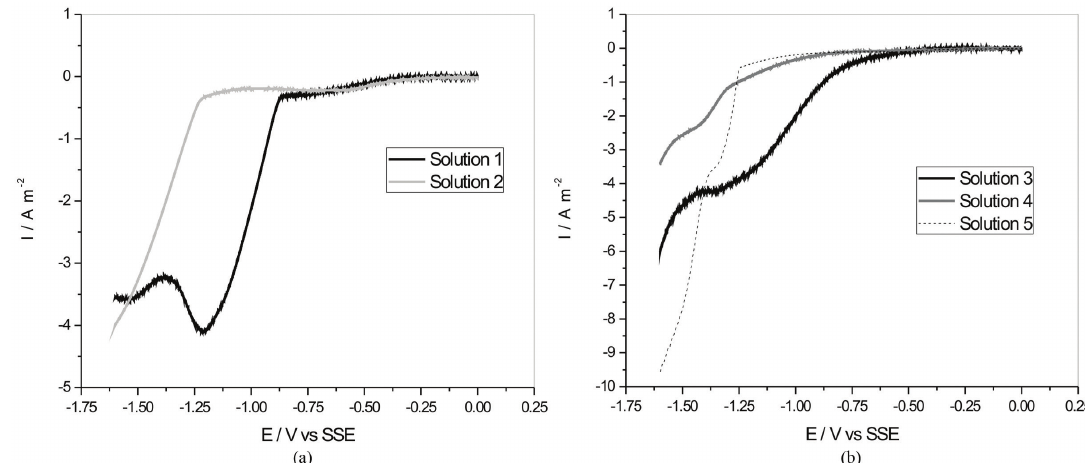
Figure 1. Cathodic scans of the solutions containing one of the ions (Co (II) or Zn (II)), without (a) or with (b) citrate. Figure 1b also shows the cathodic linear voltametric curve of the graphite substrate in solution 5 of Table